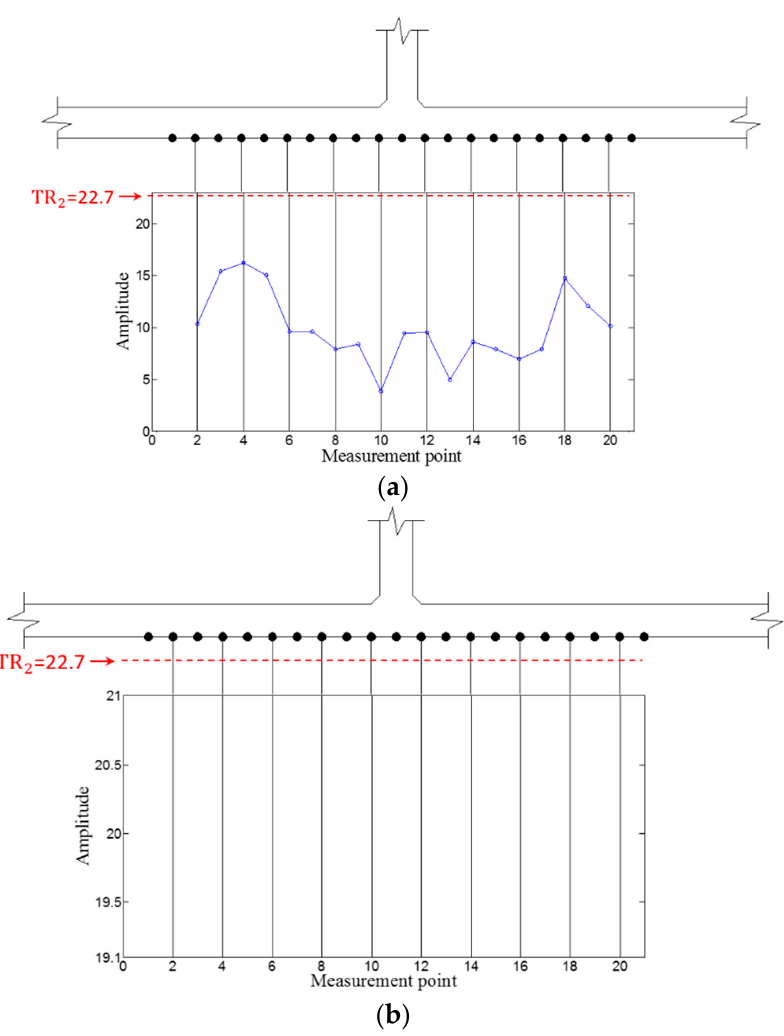
Figure 17. ZLCC values obtained from the crack area at 100 kHz ( a ) before and ( b ) after applying TR 2 .